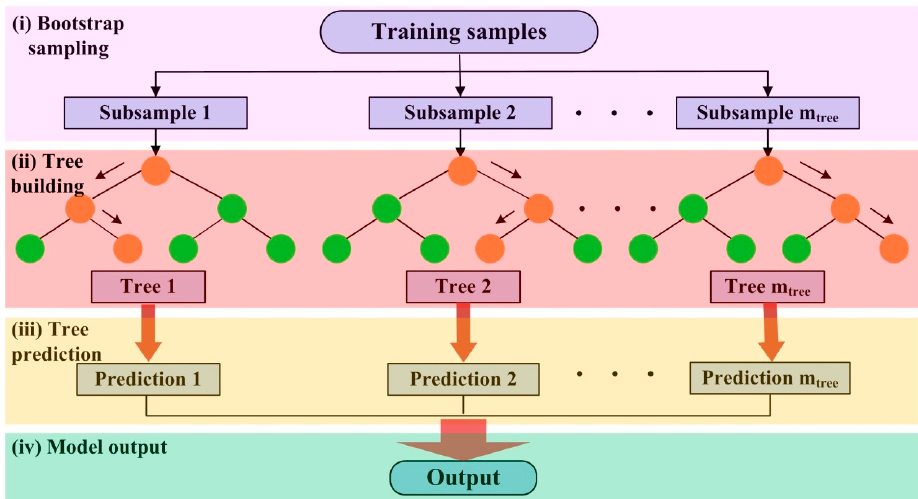
Figure 5. Working flowchart of random forest (RF).